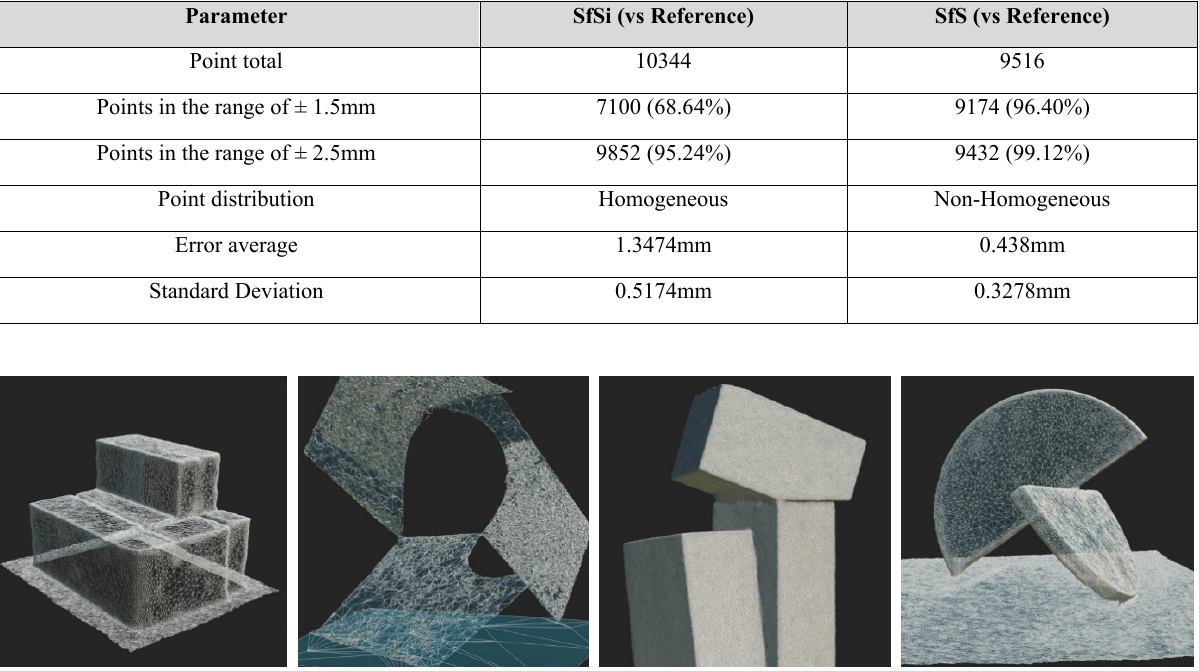
Figure 7. Database of digitized Oteiza’s sculptures based on the proposed